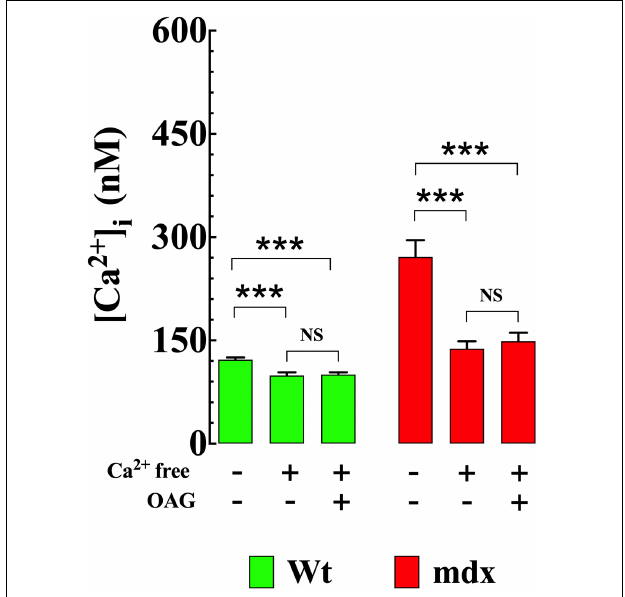
channel blocker. Nifedipine had no significant effects on OAG- induced elevation of [Ca 2 + ] i in either Wt or mdx VSMCs ( Supplementary Figure S1